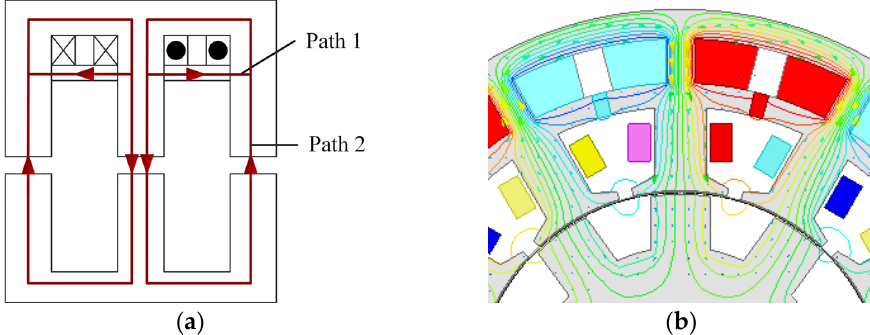
Figure 3. Magnetic flux paths of electric excitation: ( a ) theoretical paths; ( b ) FEA paths.